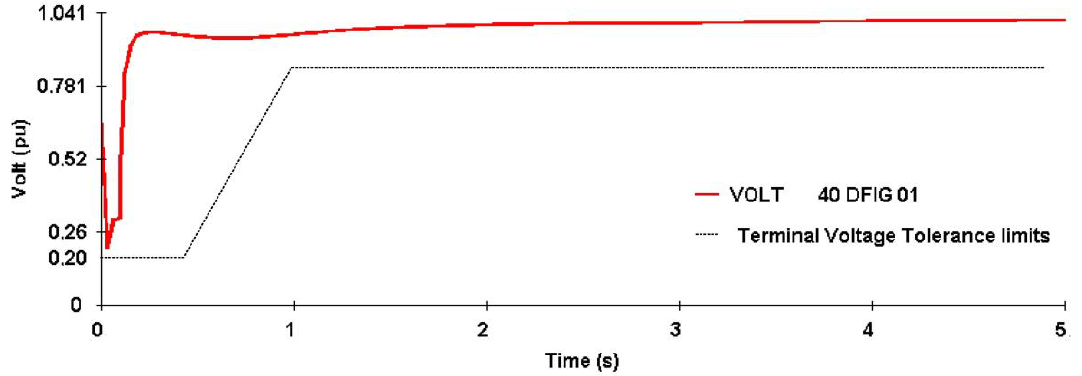
Figure 13. Terminal voltage of the DFIG at bus 40 after the short circuit with the decision tree (DT) rules and optimization of FLUPOT.